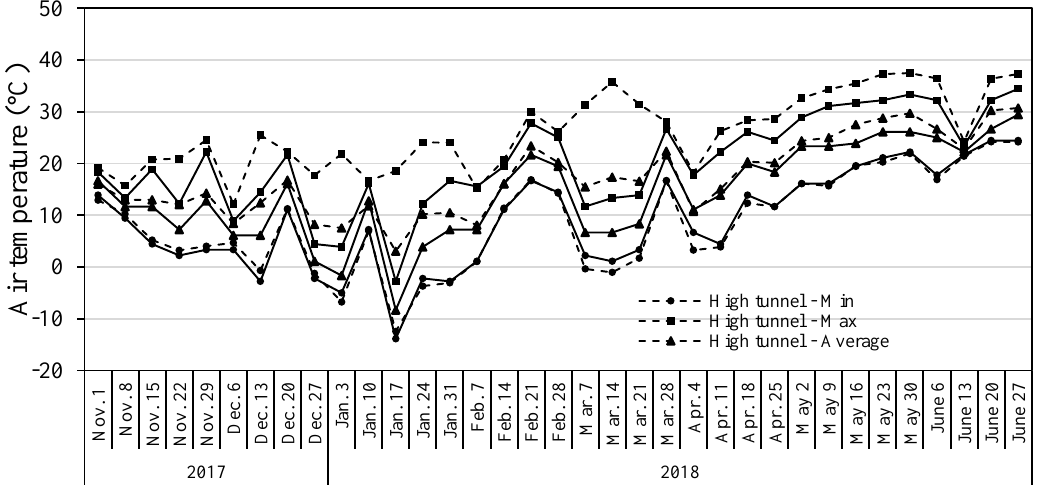
Figure 1. Daily minimum, average, and maximum air temperatures in the high tunnel and outdoors from November 2017 to June 2018 in Starkville, Mississippi. Air temperatures in the high tunnel were recorded using a temperature and relative humidity sensor (HOBO S-THB-M002; Onset Computer Corp.); local outdoor air temperature data were obtained from the United States Department of Agriculture (USDA) Natural Resources Conservation Service website.